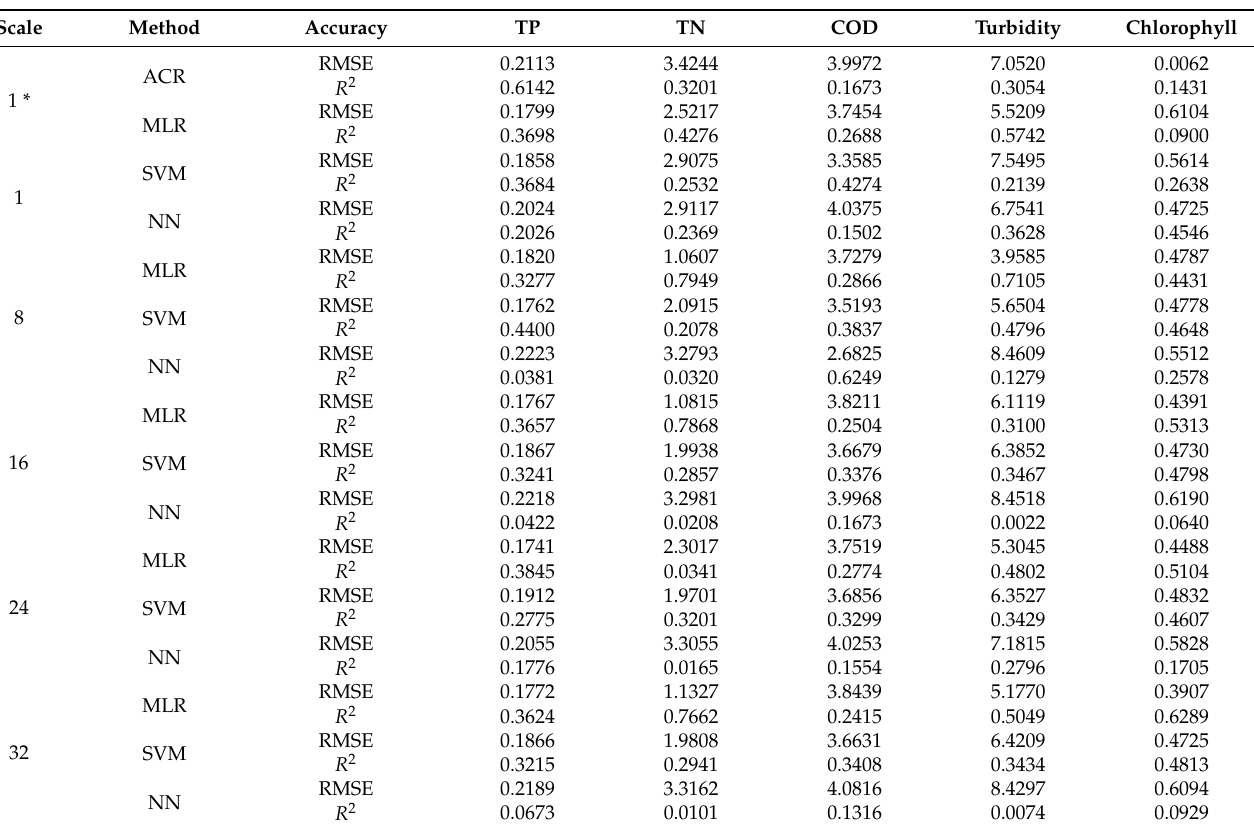
Table 2. Regression results for the water quality